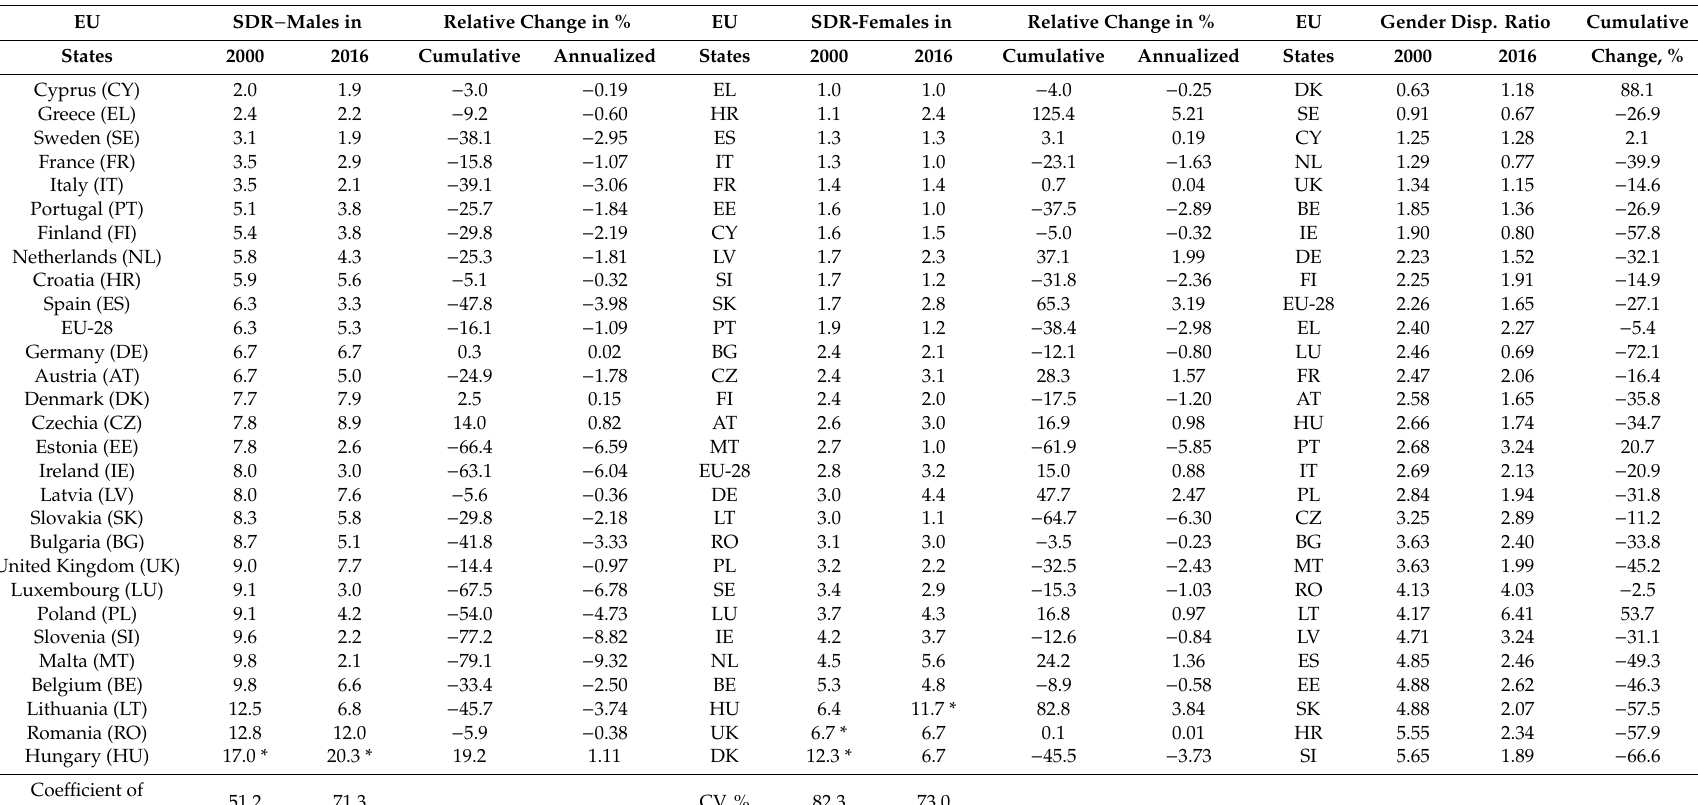
Table 7. Premature SDR for chronic lower respiratory diseases in the EU countries in 2000 and 2016 1